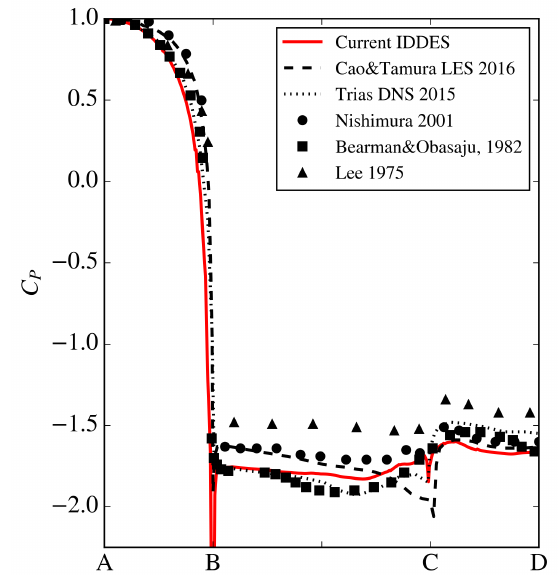
Figure 7. Surface pressure coefficient taken at center plane ( H ∗ z = 0) in comparison with highly resolved numerical computations and